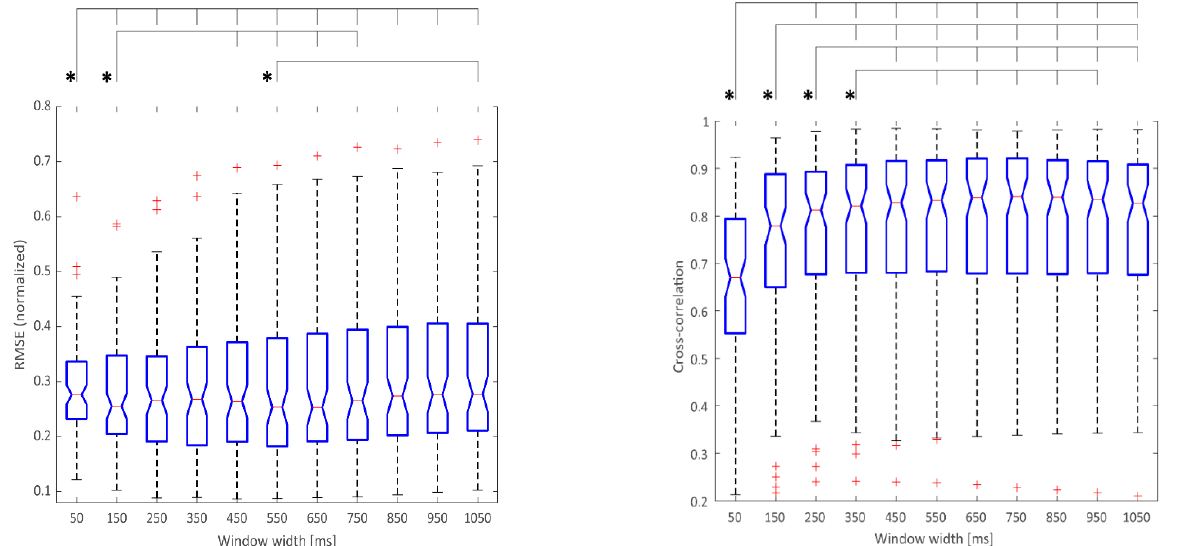
Figure 6. RMSE ( left ) and cross-correlation ( right ) of MAV algorithm for different window sizes. The cases of significant differences ( p < 0.05; Bonferroni-corrected) are marked with *.